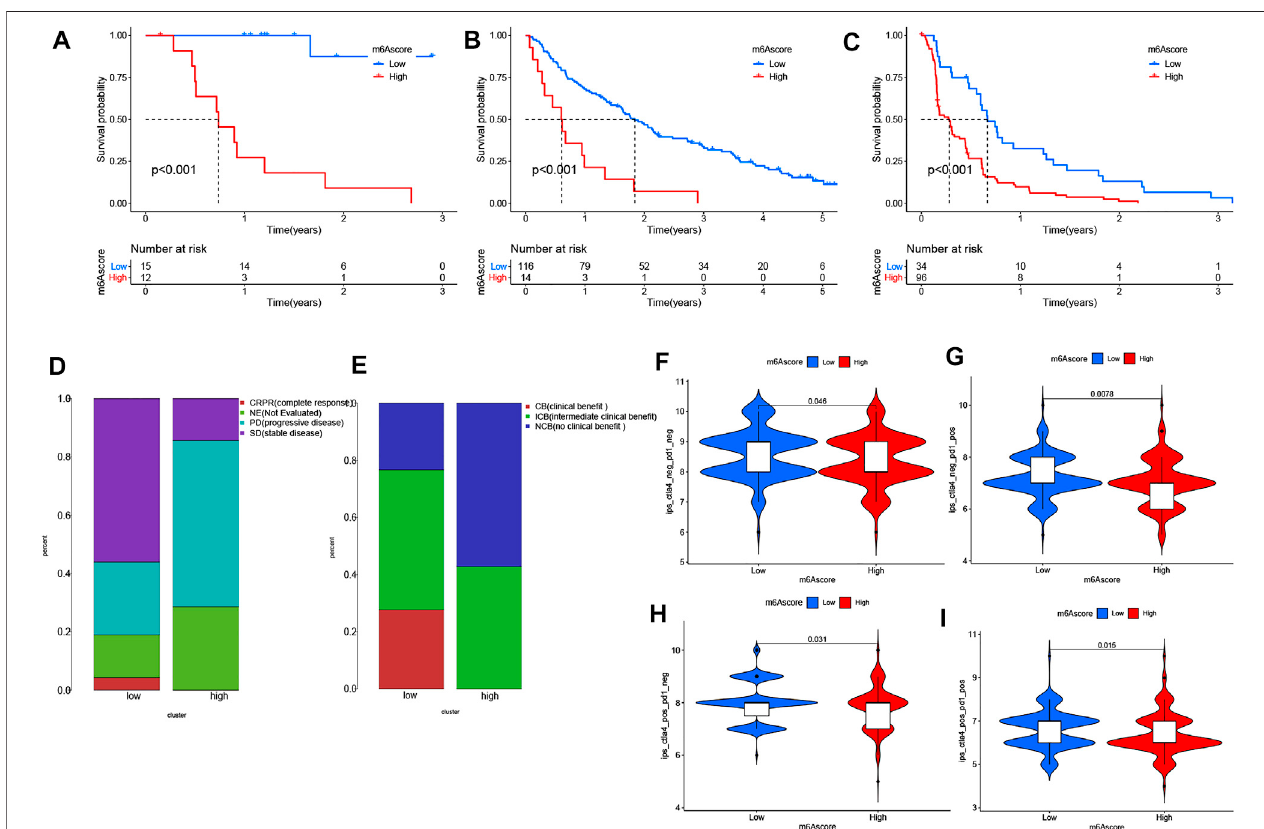
FIGURE6| Theroleofdistinctm 6 Amodi fi cationpatternsinimmunotherapy. (A – C) Resultsshowingtheassociationsofm6Ascorewasnegativelyassociatedwith OS and PFS following (A , B) anti-PD-1 therapy or (C) use of mTOR inhibitors. Negative associations were observed in both cases. (D , E) Proportions of PRCC patients with (D) an immunotherapy response and (E) clinical bene fi t in the two m6Ascore sets. (F – I) Relationship between m6A score and immunotherapeutic response under PD-1 and CTLA-4 expressions: (F) negative PD-1 and CTLA-4. (G) positive PD-1 and negative CTLA-4. (H) positive CTLA-4 and negative PD-1. (I) positive PD-1 and